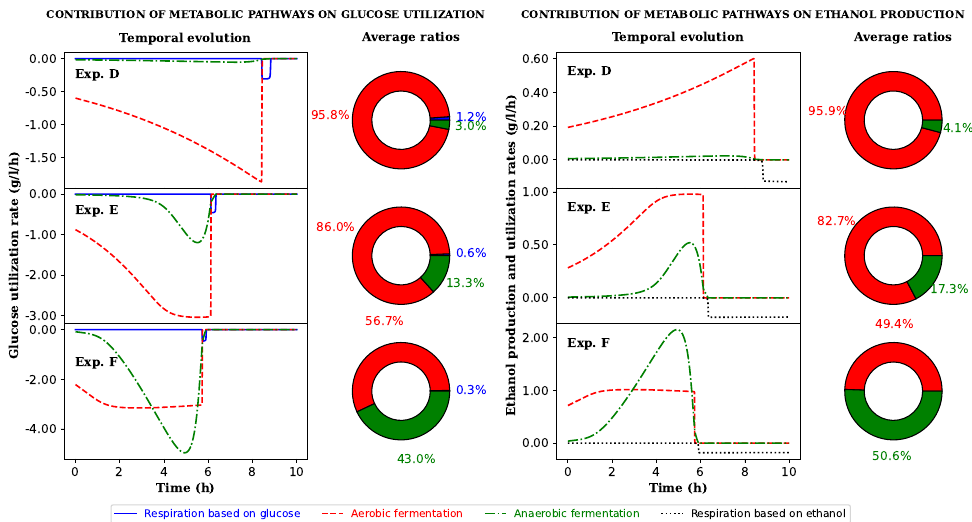
Figure 7. Contribution of individual metabolic pathways to glucose utilization and ethanol produc- tion: temporal evolution during fermentation (line graphs) and time − average of the stoichiometric ratios (pie graphs). Ethanol consumption by respiration once glucose is depleted is not considered in the time − average of the stoichiometric ratios for ethanol